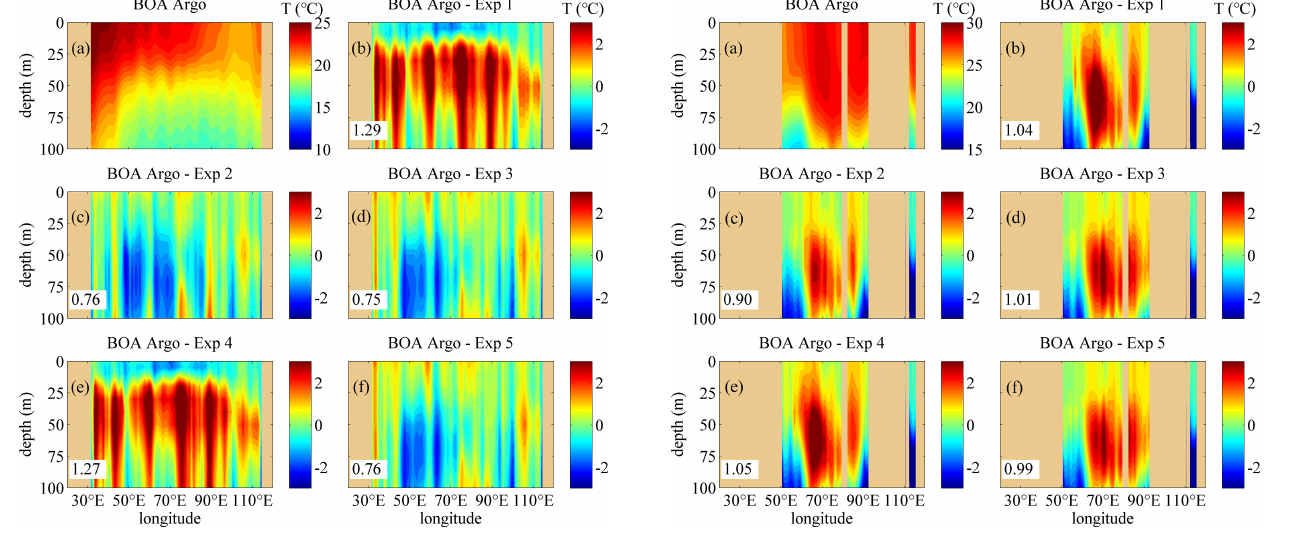
Figure 10. The vertical temperature profiles along 30.5 ◦ S in Jan- uary. (a) The temperature structure from the monthly BOA-Argo data (units: degrees). (b–f) The difference of the temperature calcu- lated by subtracting the monthly mean results simulated in Exp 1– Exp 5 from the monthly BOA-Argo data, respectively. The RMSEs of the temperature in the upper 100m regions between the BOA- Argo data and the model results are given. Deep yellow areas cor- respond to land.